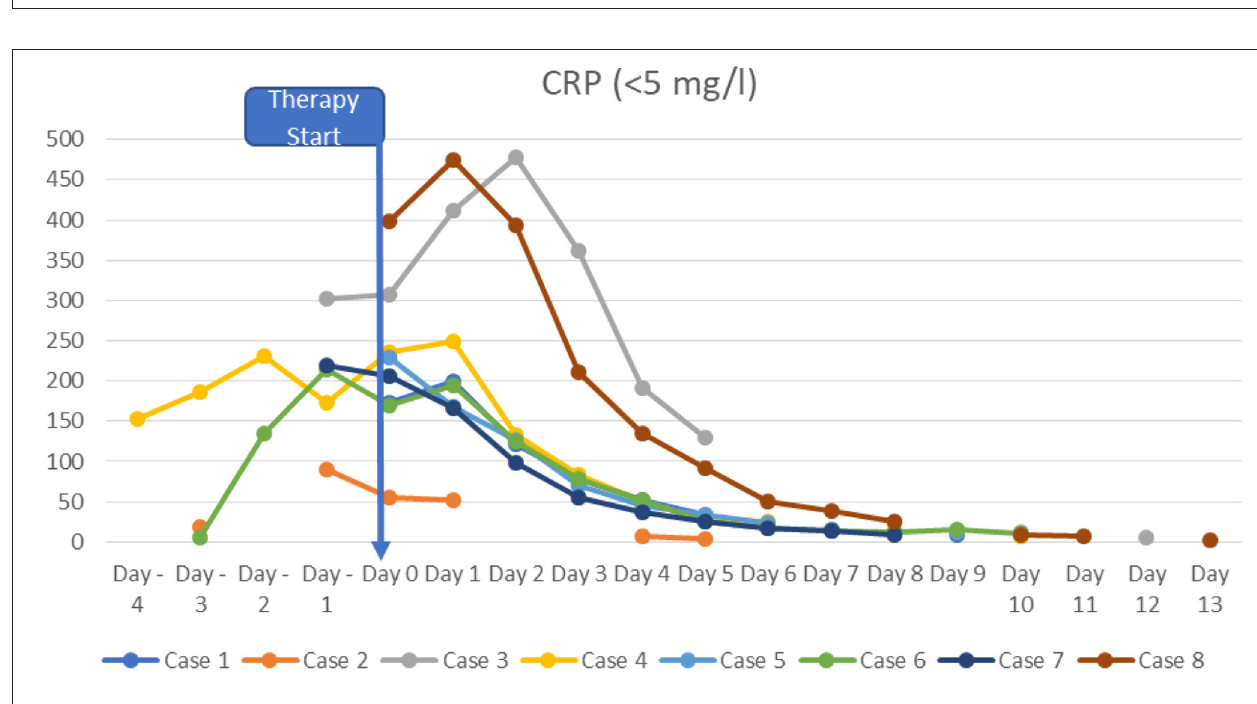
FIGURE 1 | Curves of daily maximal temperature.